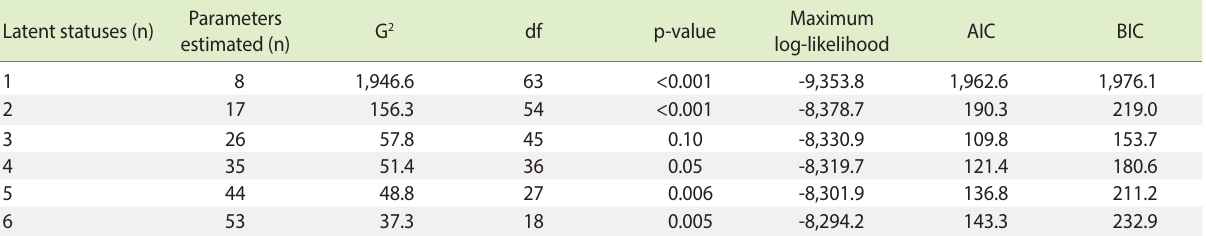
Table 2. Comparison of LCA models with different latent classes according to the model selection statistics Latent statuses (n)